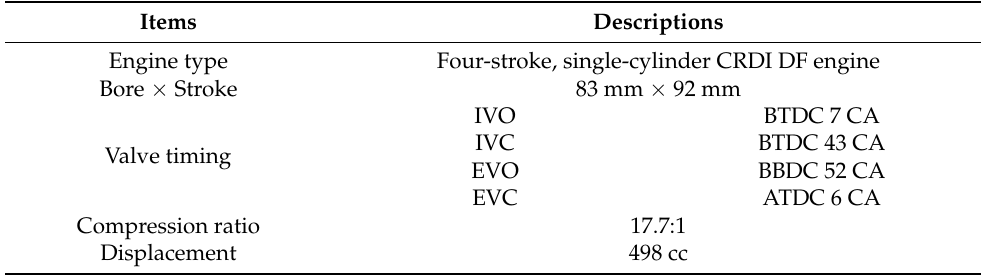
Table 1. Main specifications of the test engine.